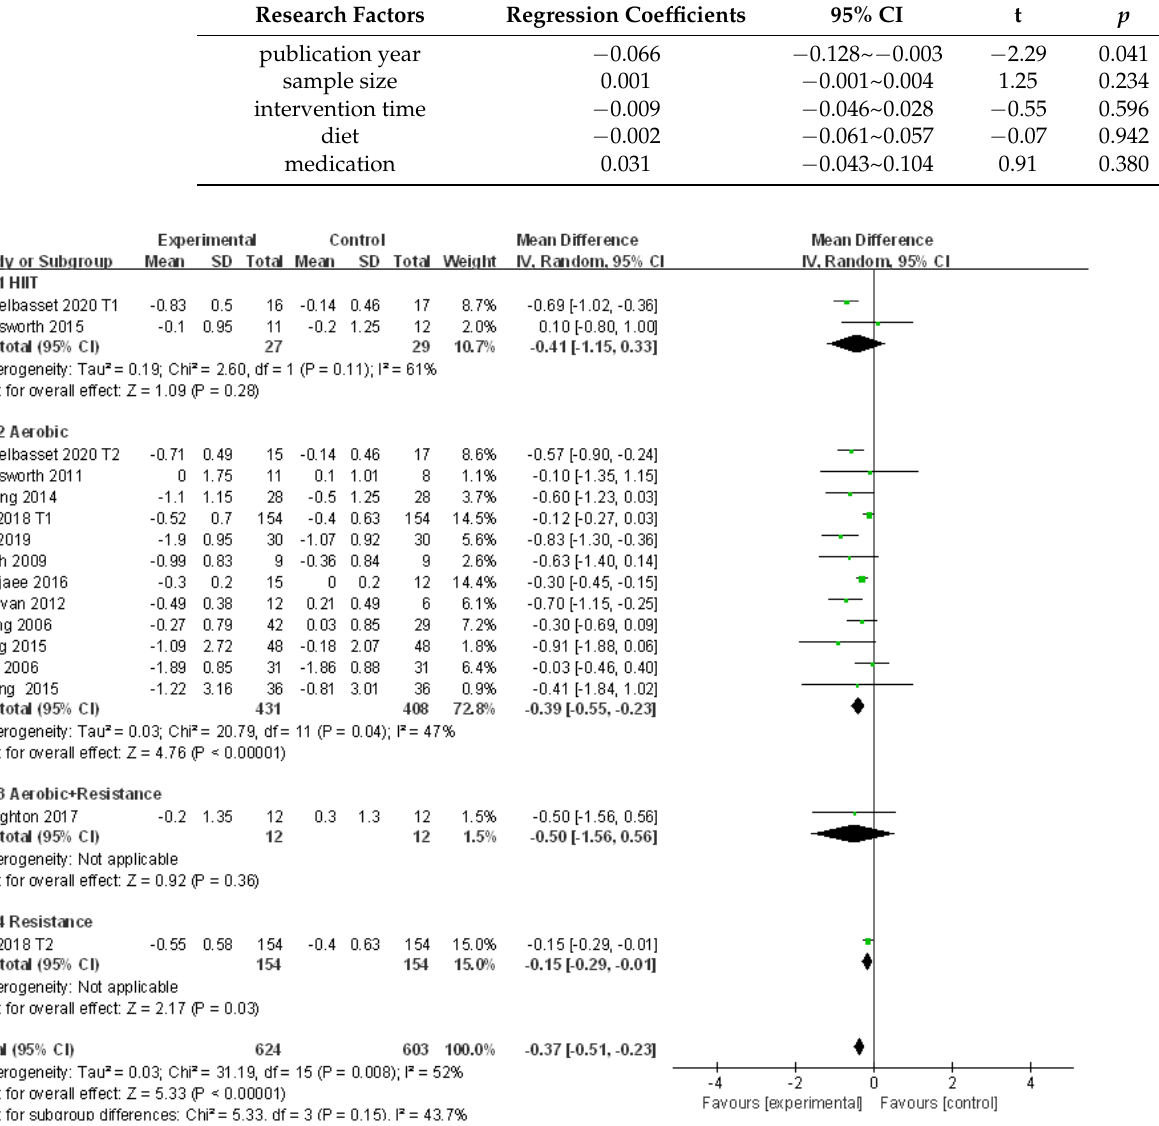
Table 3. Meta regression analysis of heterogeneous factors of TC.